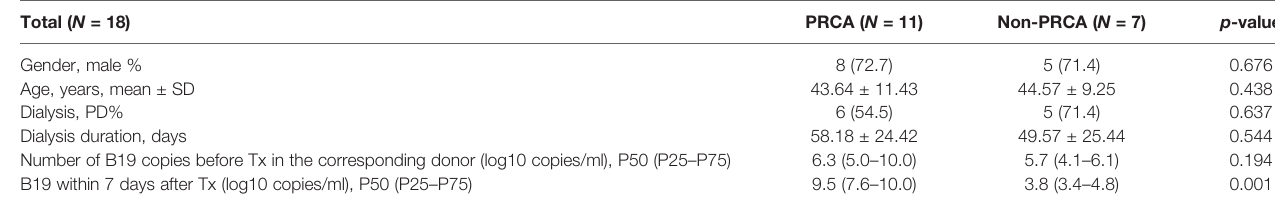
TABLE 3 | Comparison between the PRCA group with the non-PRCA group in a total of 18 donor-deprived parvovirus B19 infection in deceased donor kidney transplantation. Total ( N = 18) PRCA ( N = 11) Gender, male %